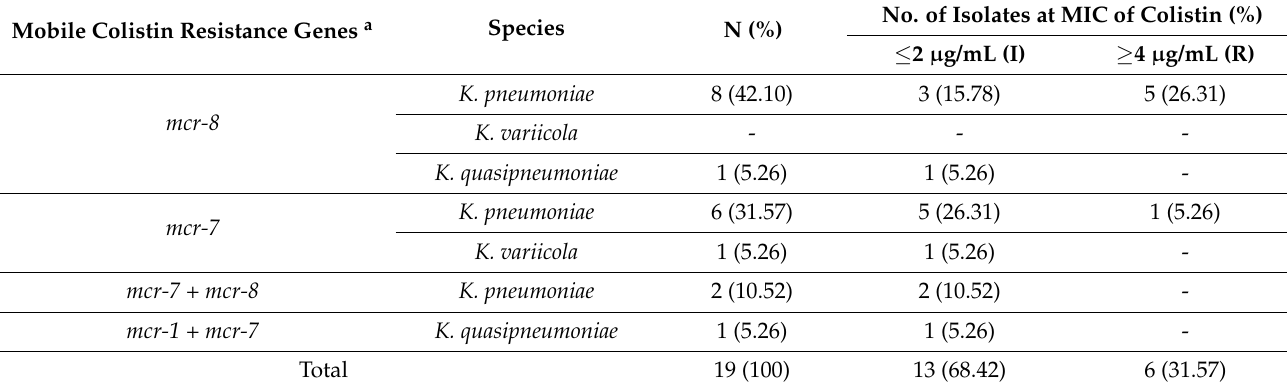
Table 2. MIC values of colistin in KpnC harboring mcr